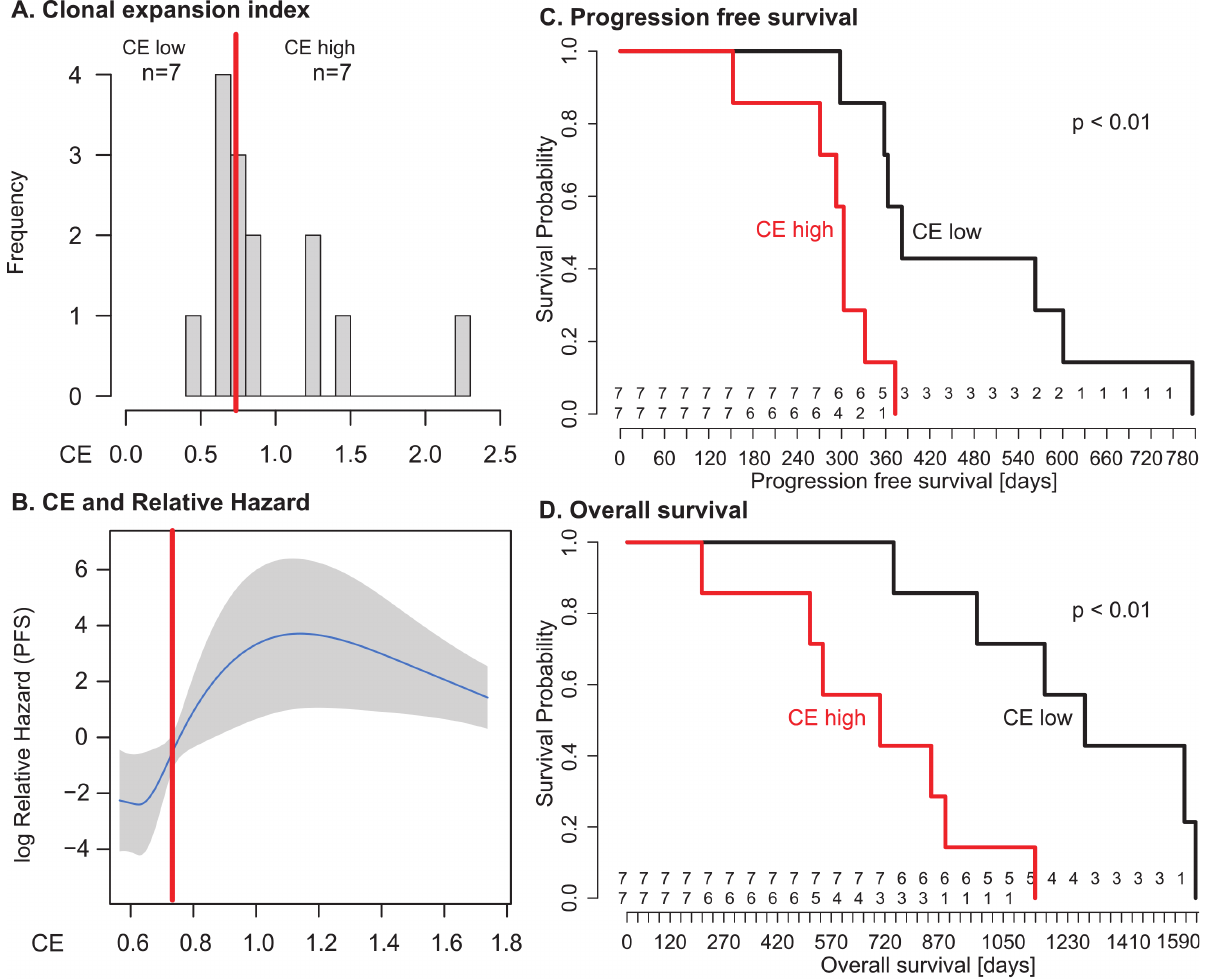
Fig 5. Clonal expansion index stratifies patients into prognostic subgroups. (A) Distribution of CE index over all patients and the respective group sample sizes ( n ). The red line indicates median CE = 0.73, dichotomizing the cases into equal-sized CE-low and CE-high groups. (B) The relationship between CE and relative hazard is nonlinear. The fit line is generated from the multivariable model incorporating penalised spline smoothing. Grey shading indicates the 95% confidence interval for log hazard. Extreme CE values are not shown as the spline smoothing algorithm disregards values outside the 95% range. The median (red line) separates a region of low hazard from a region of high hazard indicated by non-overlapping confidence intervals. (C and D) The CE-low and CE-high groups show a statistically significant difference in PFS (log-rank p < 0.01) and OS (log-rank p < 0.01). Numbers at risk are given above the x -axis for the CE-low (top) and CE-high (bottom)